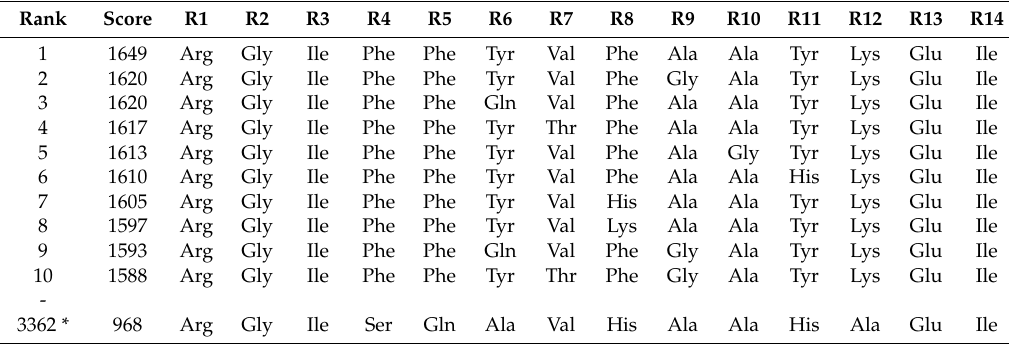
Table 2. Result of the second AutoLudi screening. The top ten peptide sequences with the highest Ludi score are listed. * The original